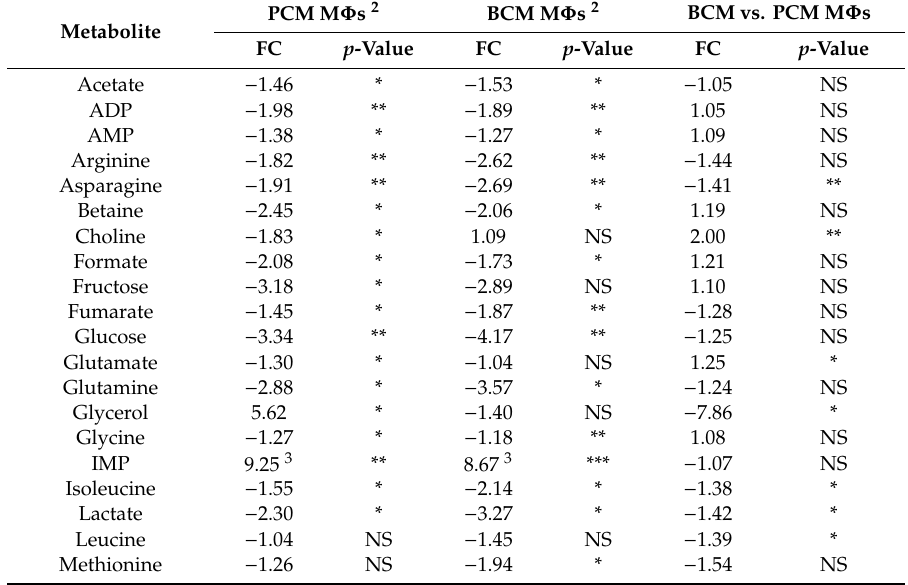
Table 1. Discriminatory metabolites in intracellular extracts associated with 1 h PCM and BCM exposure 1 . Metabolite